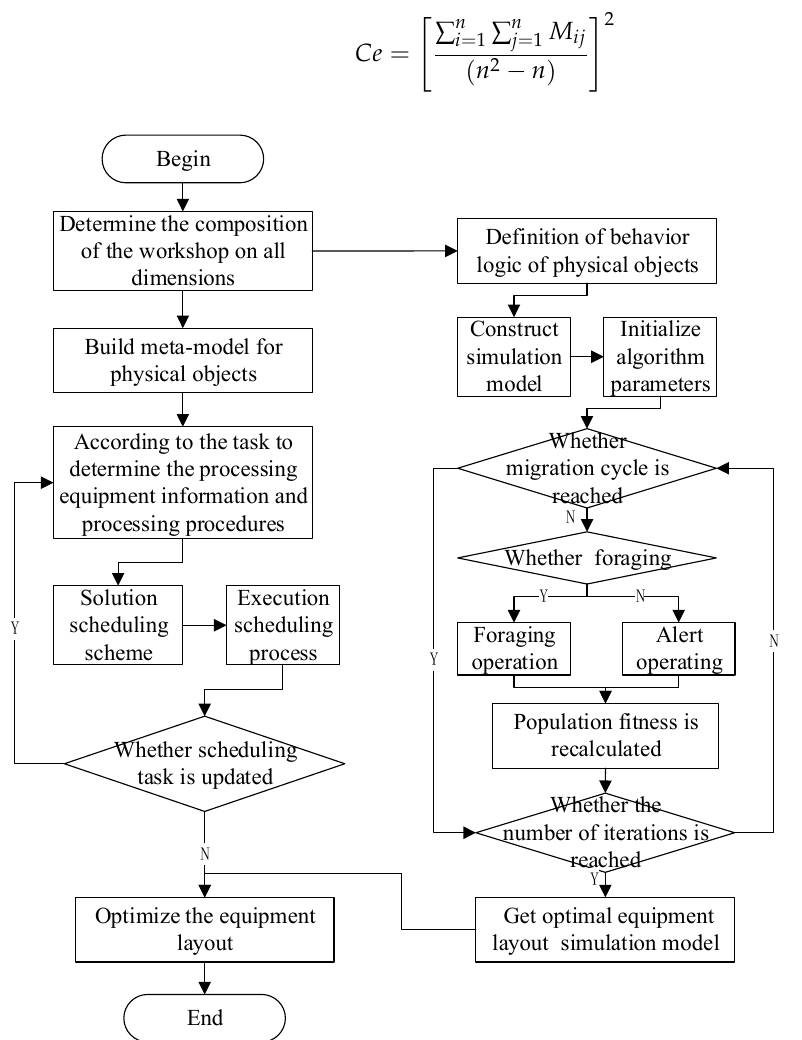
Figure 5. Simulation process based on particle swarm optimization algorithm.